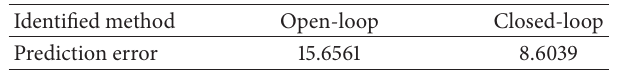
Table 1: The prediction errors of open-loop and closed-loop identified hair dryer